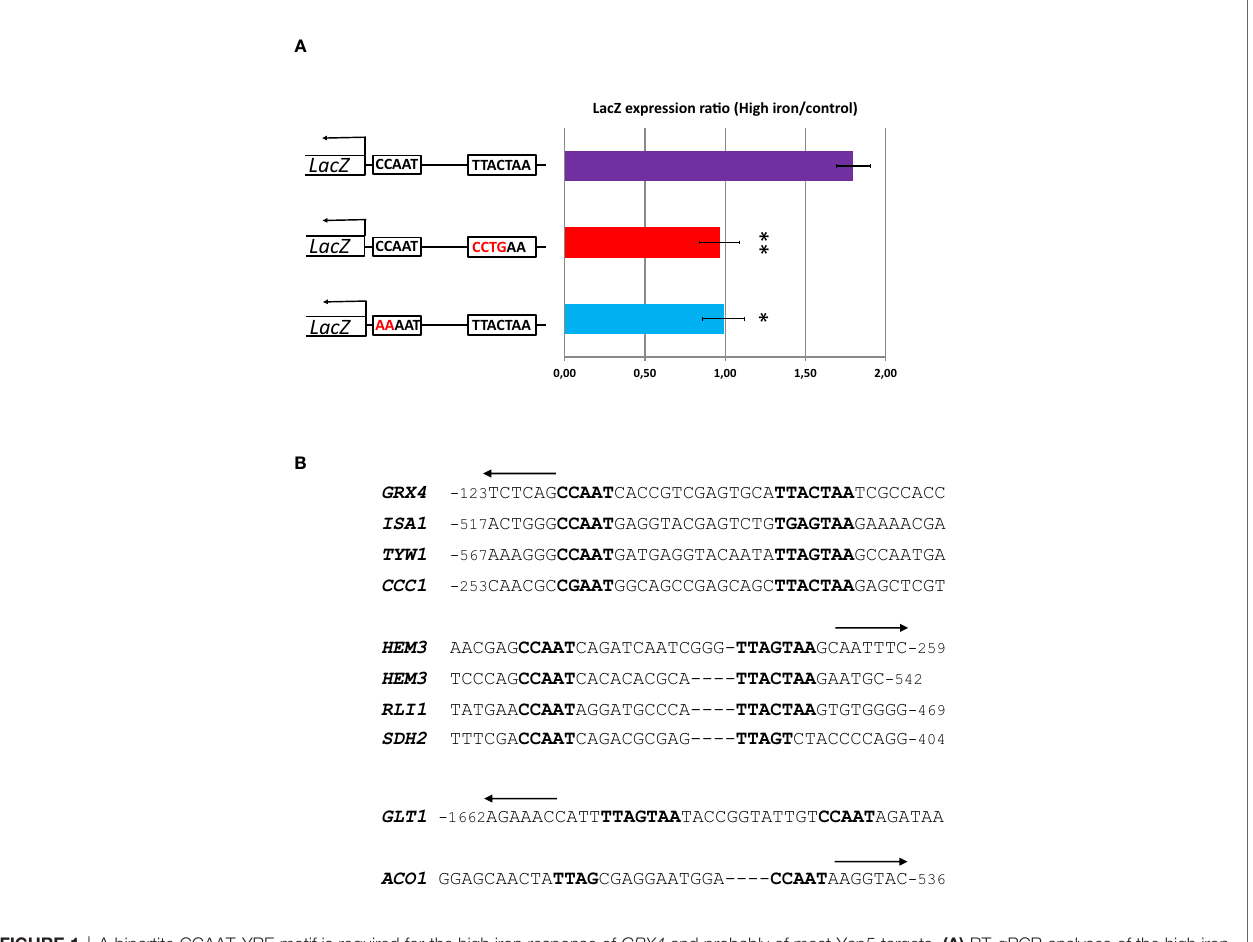
FIGURE 1 | A bipartite CCAAT-YRE motif is required for the high iron response of GRX4 and probably of most Yap5 targets. (A) RT-qPCR analyses of the high iron response (glucose + 2 mM FeSO 4 ) of a LacZ reporter driven by different versions of the GRX4 reporter. First line: wild type version. Second line: Mutant version in which the YRE (TTACTAA) of the wild type version has been changed into CCTGAA. Third line: Mutant version in which the CCAAT of the wild type version has been changed into AAAAT. The values represent the expression levels of the LacZ reporter relative to ACT1 (used as an internal control) and to the wild type grown in glucose with normal iron concentration. The experiments were performed two times on biologically independent samples. Error bars hence represent the standard error of the mean. The results of a t-test comparing the results of the wild type version with the YRE mutation and the CCAAT mutation, respectively, are symbolized as follows: **p < 0.05, *p < 0.1. (B) Multiple alignments of the CCAAT-YRE bipartite motifs in the promoters of the 9 Yap5 targets. All sequences are oriented 5 ’ -3 ’ from left to right. The arrows on top indicate the sense of transcription of the corresponding genes, i.e. an arrow oriented to the left indicates that the CCAAT-YRE motif is on the minus (non coding) strand, whereas an arrow oriented to the right indicates that the CCAAT-YRE motif is on the plus (coding) strand. The position relative to the ATG of the gene is indicated. The sequences were arbitrarily aligned on the CCAAT box and on the YRE. Gaps were added in sequences where necessary, to visualize the difference in spacing between the CCAAT and the YRE in the different